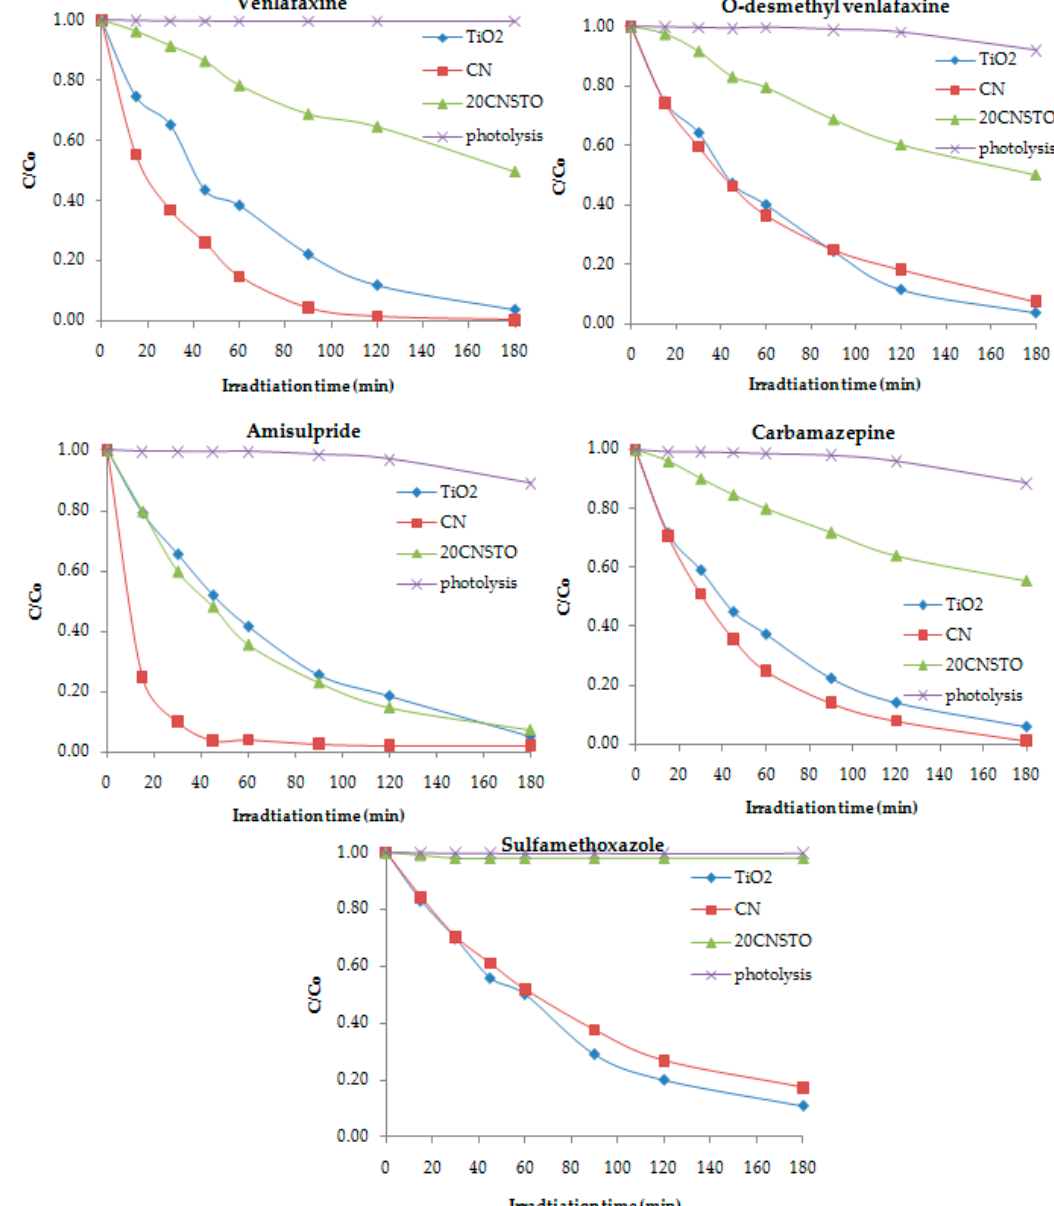
Figure 2. Photolytic and photocatalytic degradation of PhACs versus irradiation time in hospital wastewater effluent using TiO 2 , CN and 20CNSTO.